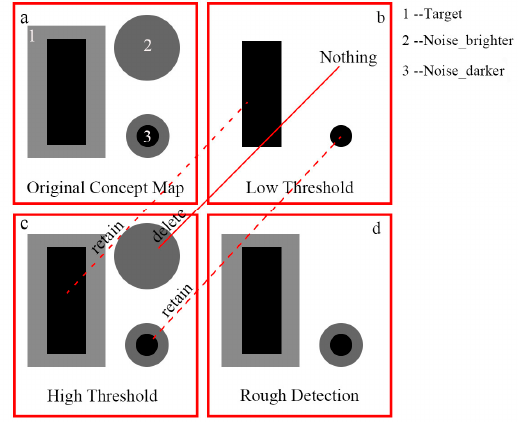
Figure 6. Concept map of Low-High threshold detection strategy. And ( a ) is the conceptual map